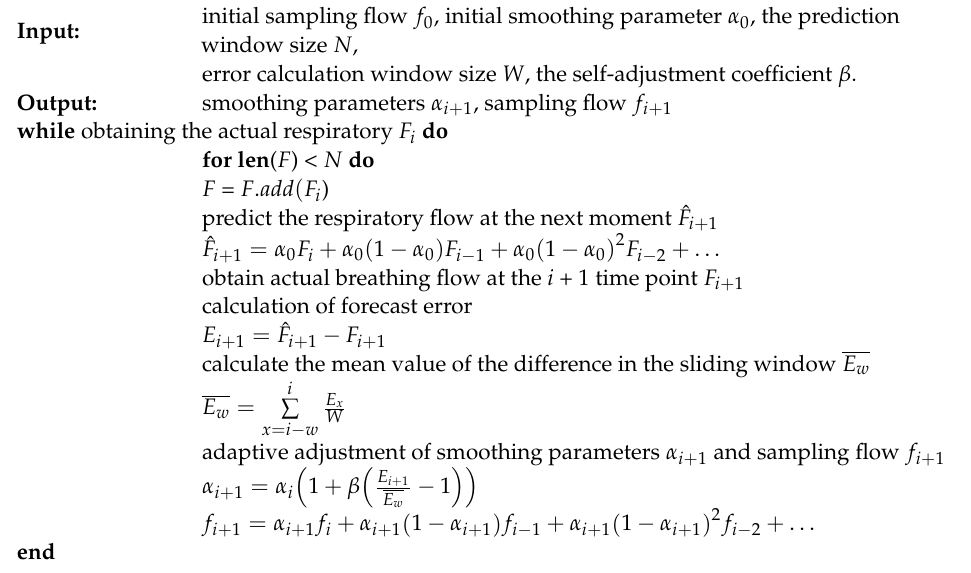
Algorithm 1: Adaptive Adjustment